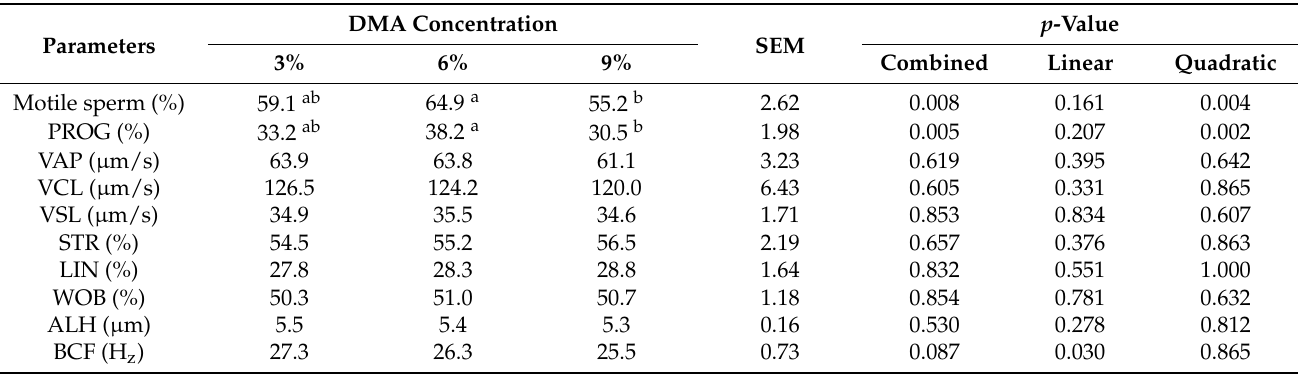
Table 2. Effect of dimethyl acetamide (DMA) concentration in semen freezing extender on the motion characteristics of rooster sperm after thawing.